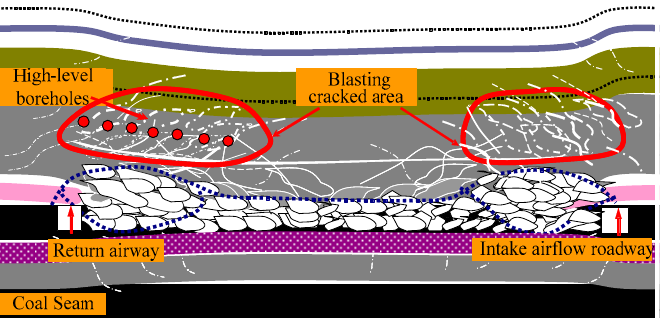
Figure 9. Schematic diagram on the gas extraction of high-level boreholes in blasting